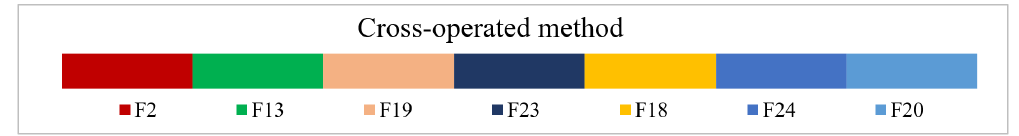
Figure 10. Optimal degradation indicator set F opt of operating condition